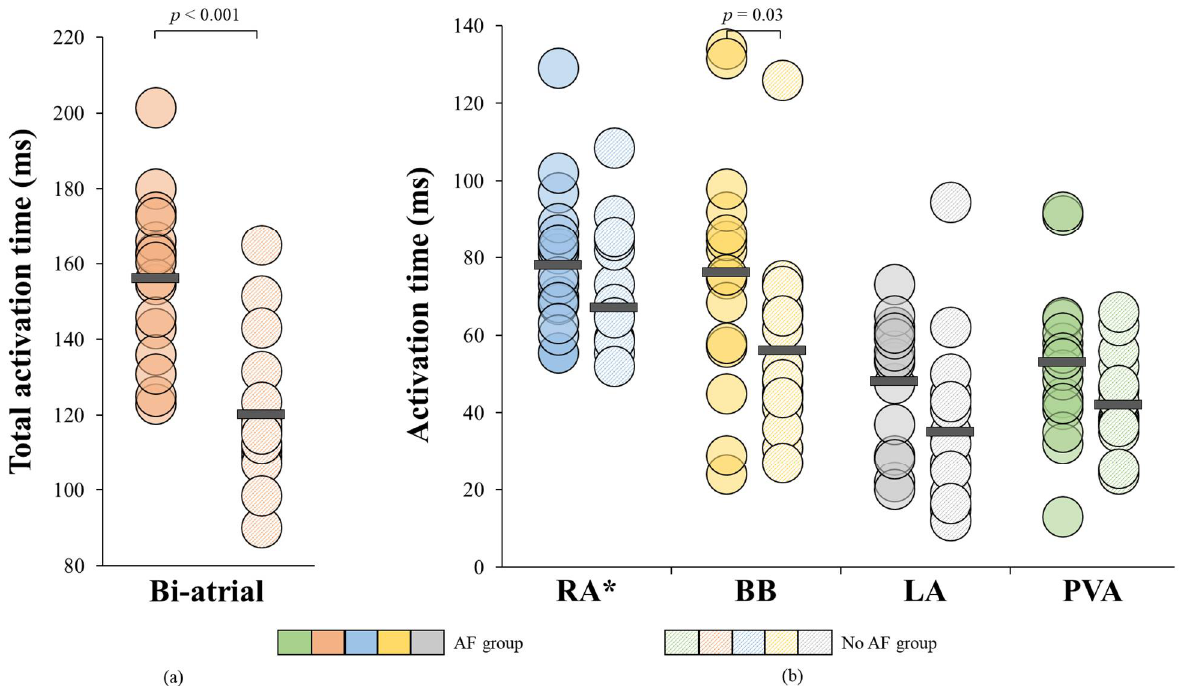
Figure 6. TAT displayed for each individual patient for the entire atria and per region separately ( a ) Biatrial TAT displayed for each individual patient; ( b ) TAT displayed for each patient per region separately. * Non-normally distributed. ms = milliseconds; BB = Bachmann’s Bundle; LA = left atrium; PVA = pulmonary vein area; TAT = total activation time; RA = right atrium.